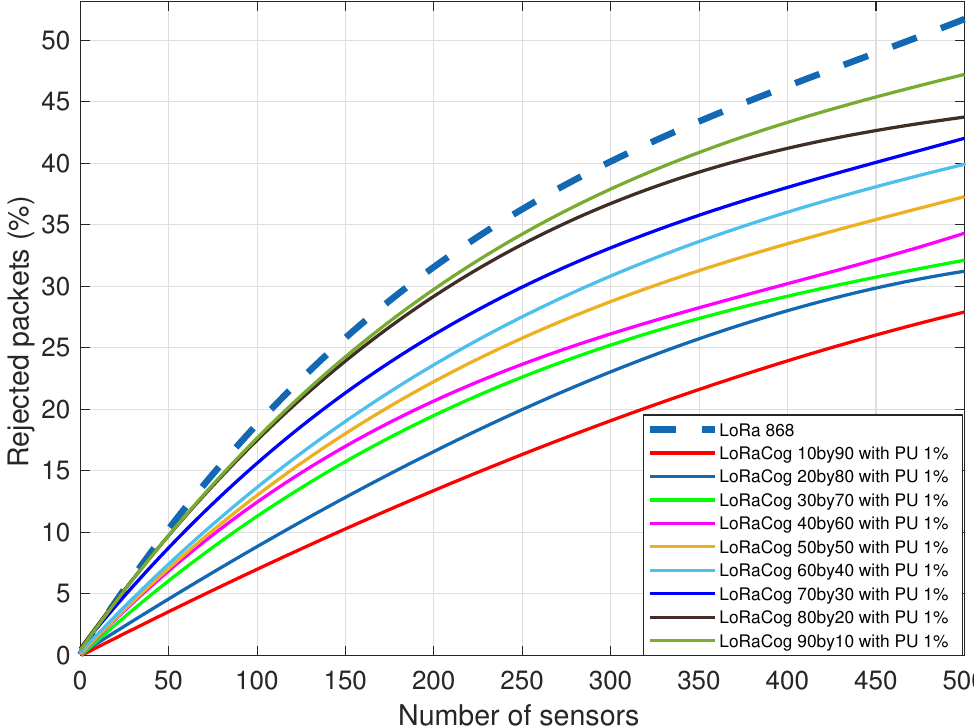
Figure 11. LoRaWAN 868 MHz vs. LoRaCog 868/438 MHz with PU